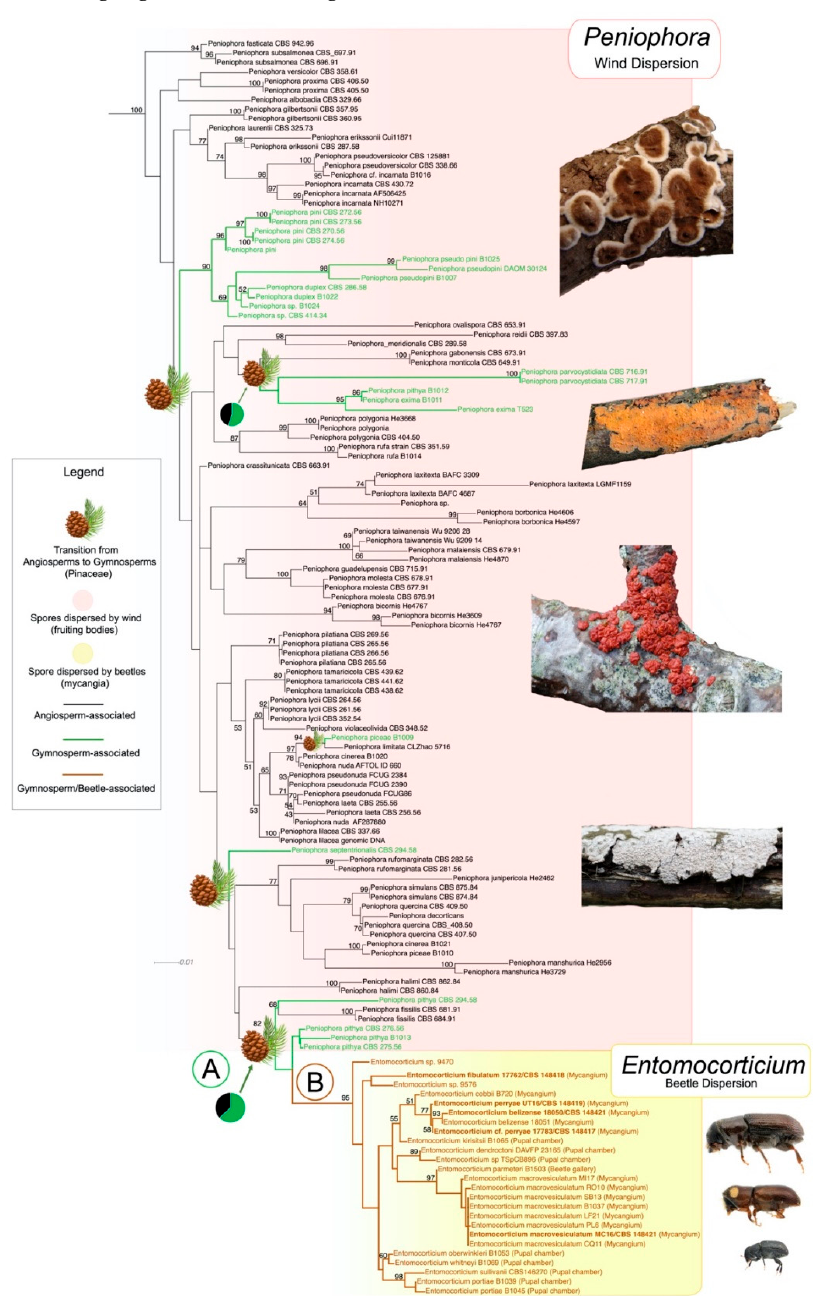
Figure 1. Maximum likelihood tree showing Peniophora/Entomocorticium clade obtained from RAxML analyses with a concatenated dataset of 5-loci (SSU, LSU, TEF, ITS and IGS). Ancestral Character State Reconstructions (ACSR) analyses based on fungal association with their plant hosts. Black branches mean association with angiosperms, green indicate an association with gymnosperms and no association with beetles, brown indicates association with gymnosperms and beetles. Pinecones indicate a transition from angiosperms to gymnosperms. Node A indicates the transition from angiosperms to gymnosperms and the origin of Entomocorticium , node B indicates fungal radiation following the association of Entomocorticium with bark beetles. Photos by Patrick Harvey, Jerzy Opioła, Eva Skific and Andrew